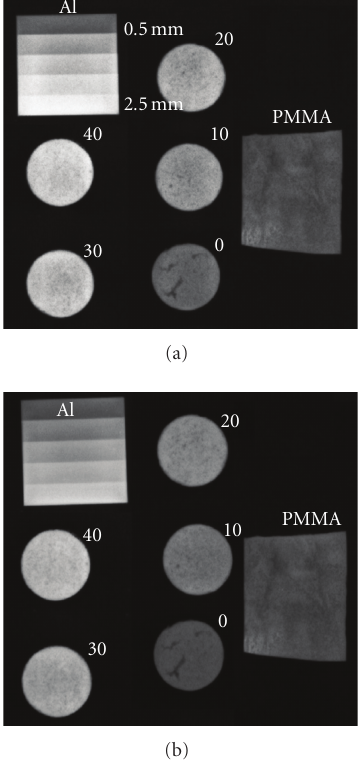
Figure 3: X-ray image comparing pCPC samples containing 0 to 40% ZrO 2 , with a commercial PMMA cement (Vertebroplastic) and an aluminium wedge with 0.5 to 2.5mm in thickness. The X-ray opacity was measured at 1mAs, with 40kV (a) and 80kV